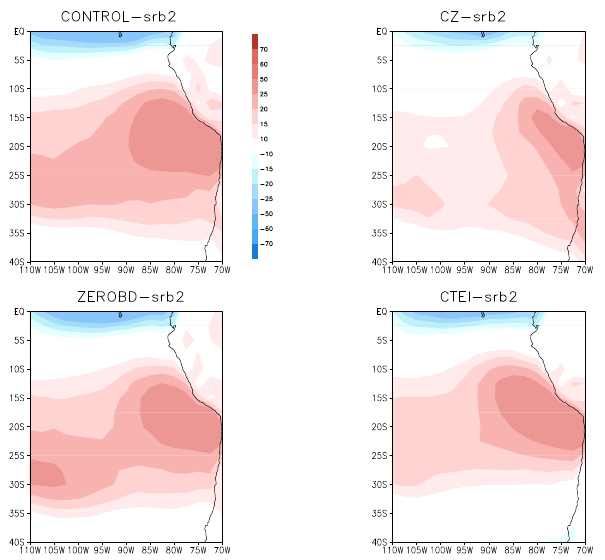
Fig. 9. As in Fig. 8 except for the longwave radiative flux errors.